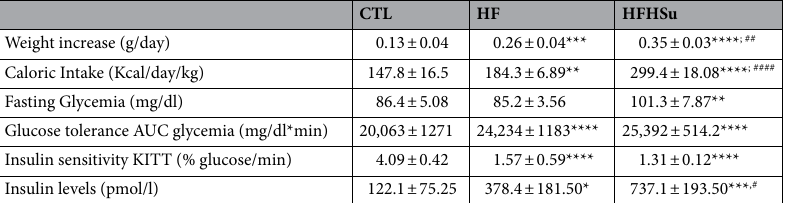
Table 1. Effect of hypercaloric diets, high-fat (HF) and high fat-high sucrose (HFHSu), on caloric intake, weight gain, insulin sensitivity and glucose tolerance in rats. Animals were submitted to HF diet (60% lipid- rich diet) during 3 weeks and to HFHSu (60% lipid-rich diet plus 35% sucrose in drinking water) during 25 weeks. Insulin sensitivity was expressed as the constant of the insulin tolerance test, K ITT . Glucose tolerance was evaluated by an OGTT and depicted as the area under the curve of the glucose excursion curve. Results are presented as mean ± SD. One-way ANOVA with Dunnet’s Multiple Comparison test: * p < 0.05, ** p < 0.01,